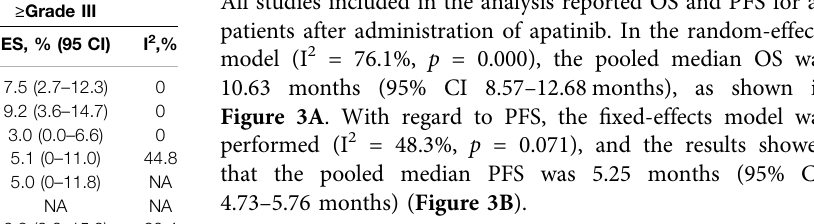
Figure 3A . With regard to PFS, the fi xed-effects model was